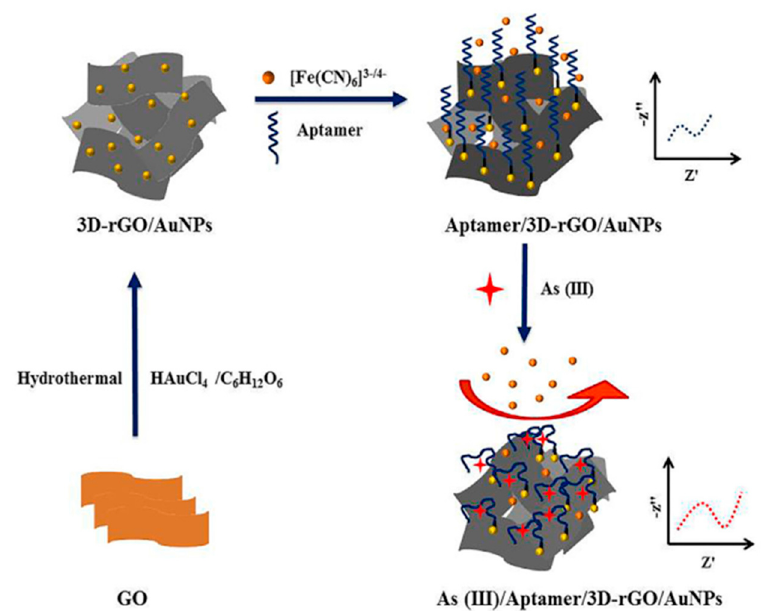
Figure 1. Scheme of the preparation and functioning of an As(III) / Aptamer / 3D-RGO / AuNPs aptasensor. Reprinted from [19], with permission.